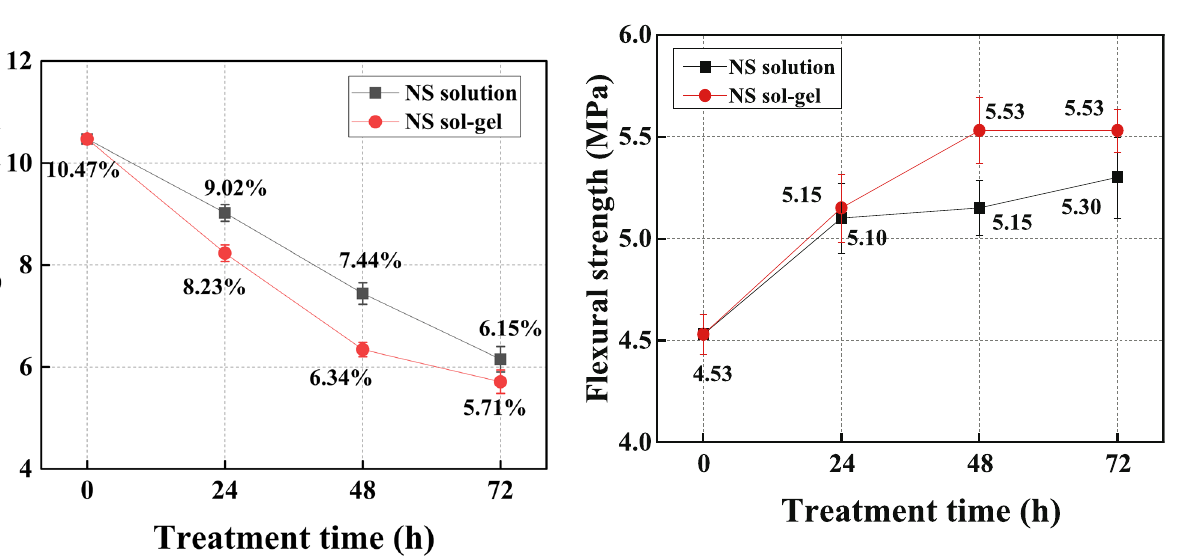
Figure 11: E ff ect of treatment time on fl exural strength of rubberised